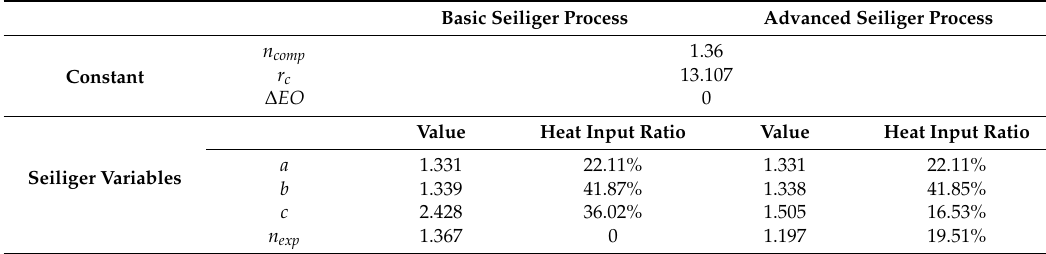
Table 5. Results of combustion fit of basic and advanced Seiliger process